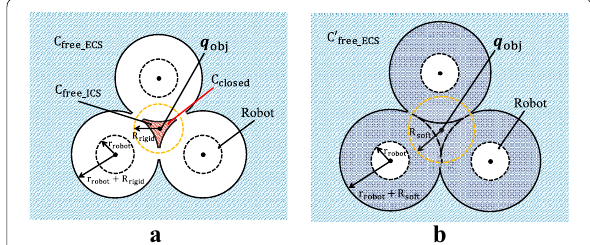
Fig. 5 Symbols in configuration space. a Caging and b caging-based